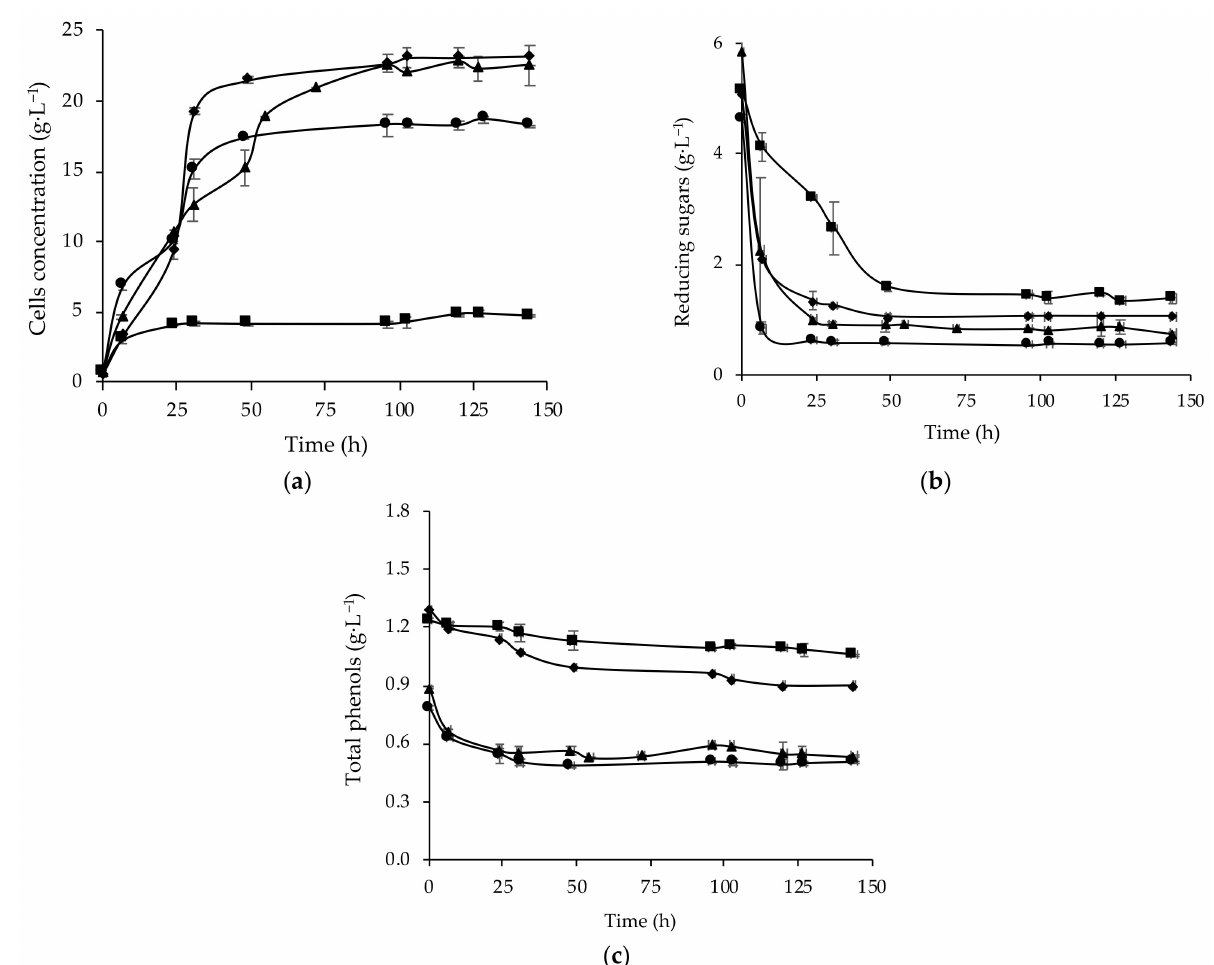
Figure 2. Time course of cellular growth ( a ), reducing sugar concentration ( b ), and total phenol concentration ( c ) obtained in C. tropicalis ATCC 750 batch cultures carried out in Erlenmeyer flasks: OMW-2 without nitrogen supplementation ( (cid:4) ); OMW-3 without nitrogen supplementation ( • ); OMW-2 + NH 4 Cl ( (cid:7) ); and OMW-3 + NH 4 Cl ( (cid:78) ). The error bars represent the standard deviation of two independent